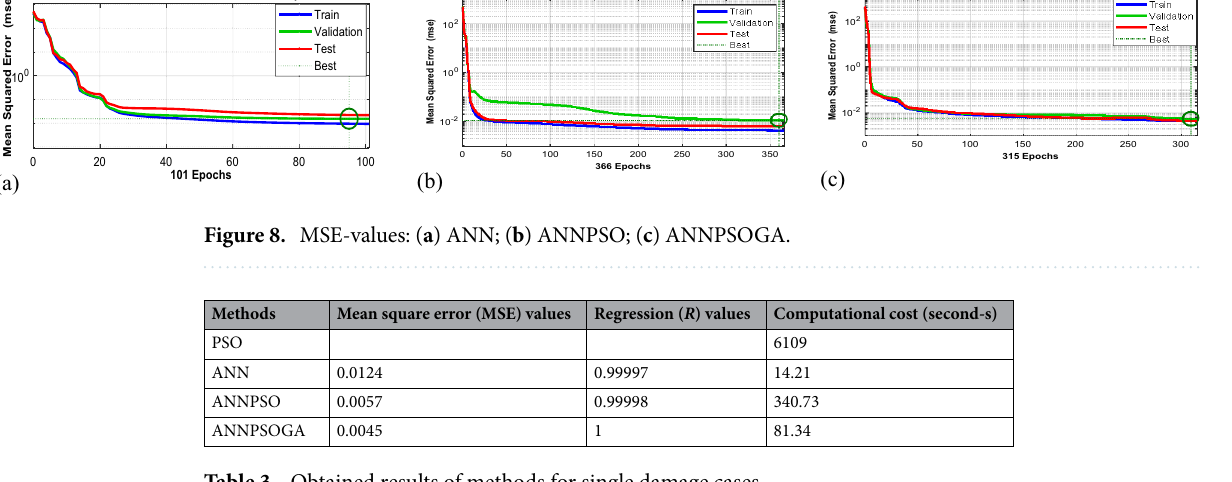
Table 3. Obtained results of methods for single damage cases.